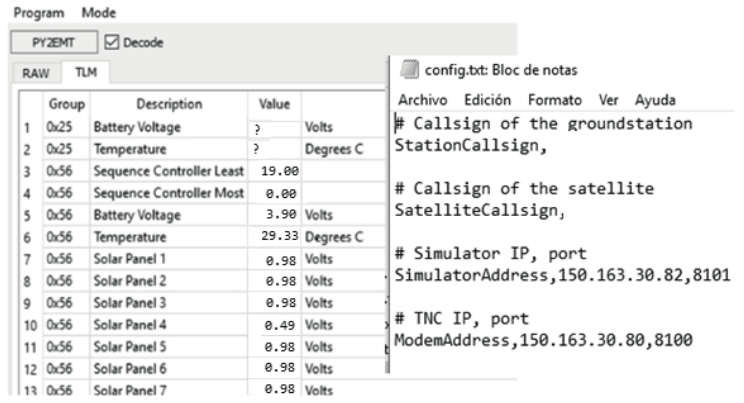
Figure 4 - UbaTM Decoder with engineering valued telemetry and configuration